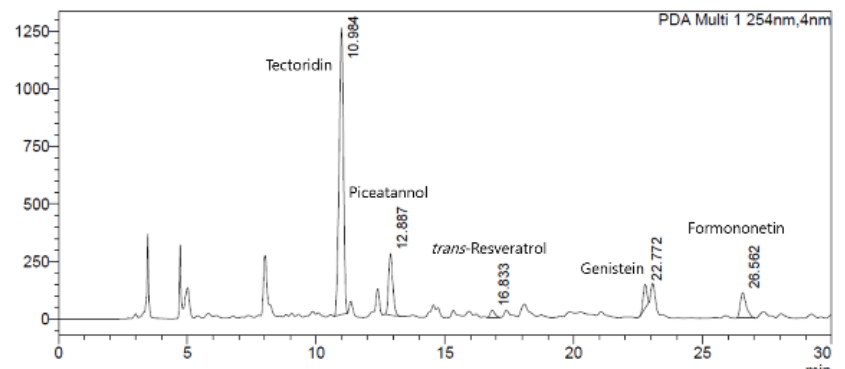
Figure 8. HPLC chromatogram of M. amurensis methanolic branch extract and five standard com- pounds (formononetin, genistein, trans -resveratrol, piceatannol, and tectoridin).